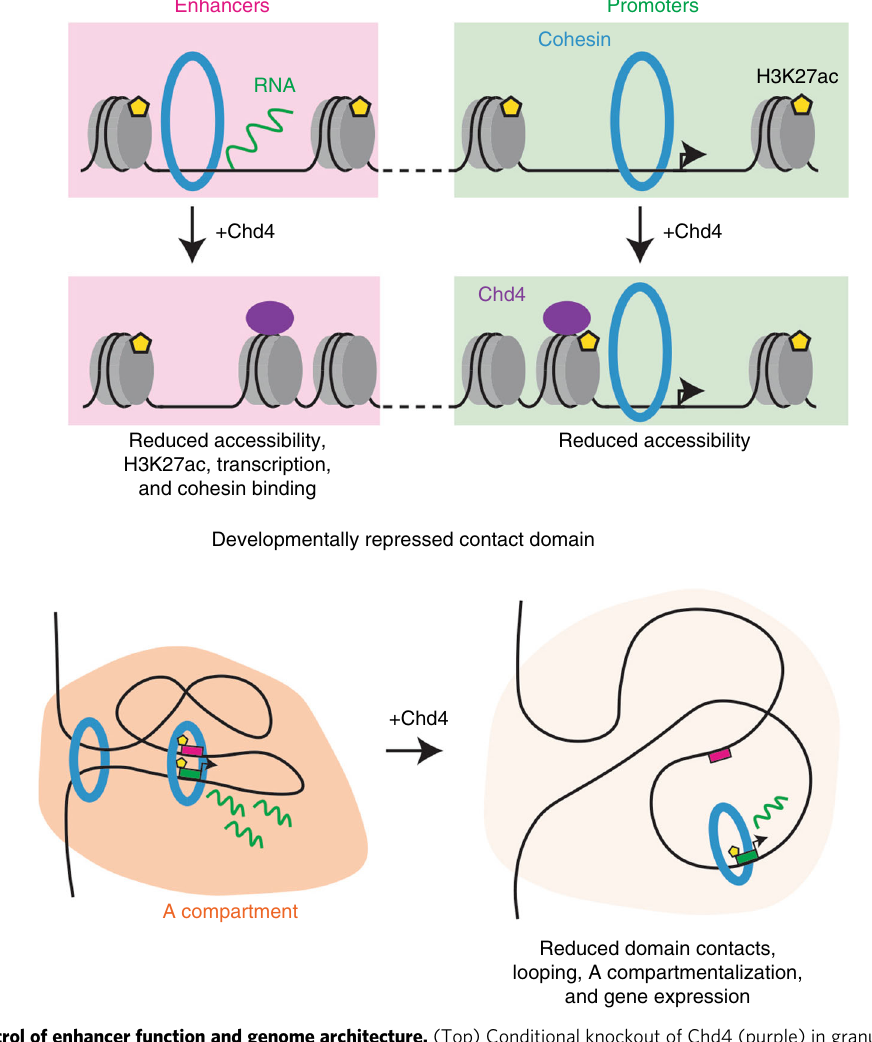
Fig. 6 Chd4 in the control of enhancer function and genome architecture. (Top) Conditional knockout of Chd4 (purple) in granule neurons of the mouse cerebellum increases the accessibility of gene enhancers (pink) and promoters (mint) genome-wide in vivo. Conditional Chd4 knockout promotes acetylation of histone H3K27 (yellow pentagons), transcription of enhancer RNAs (green lines), and cohesin complex (blue) binding speci fi cally at gene enhancers. (Bottom) Pro fi ling of genome architecture in vivo shows that conditional knockout of Chd4 strengthens domain contacts, looping at loop domain boundaries and between promoters (green) and enhancers (pink), A compartmentalization (orange), and gene expression (green lines) among developmentally repressed contact